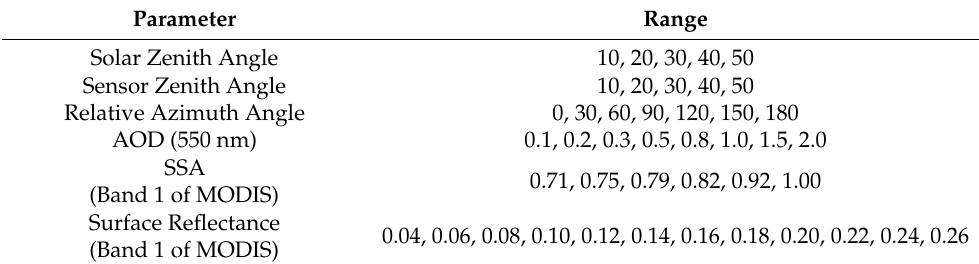
Table 4. List of input parameters of 6S model of error analysis dataset.